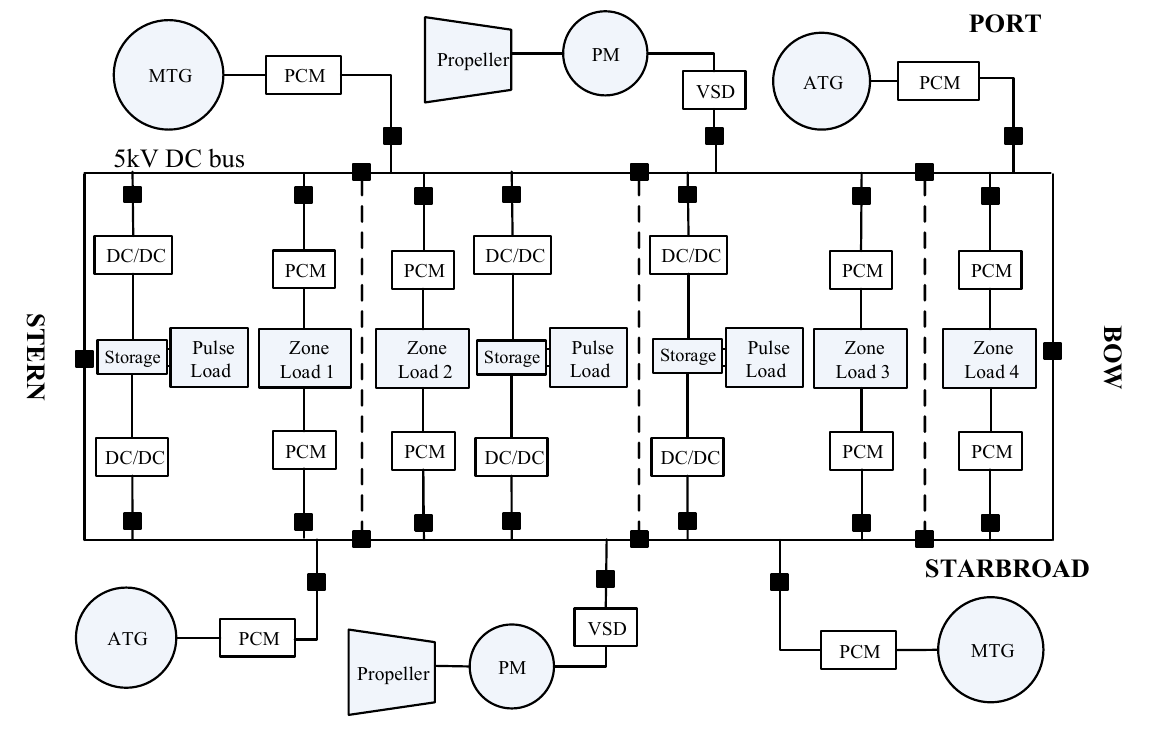
Figure 1. Schematic diagram of the four-zone SPS.